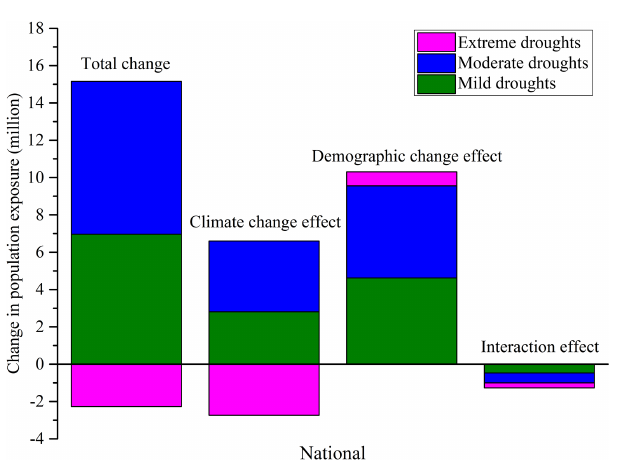
Figure 4. Decomposition of population exposure based on different effects – climate change, demographic change, and their interaction, as well as mild, moderate, and extreme